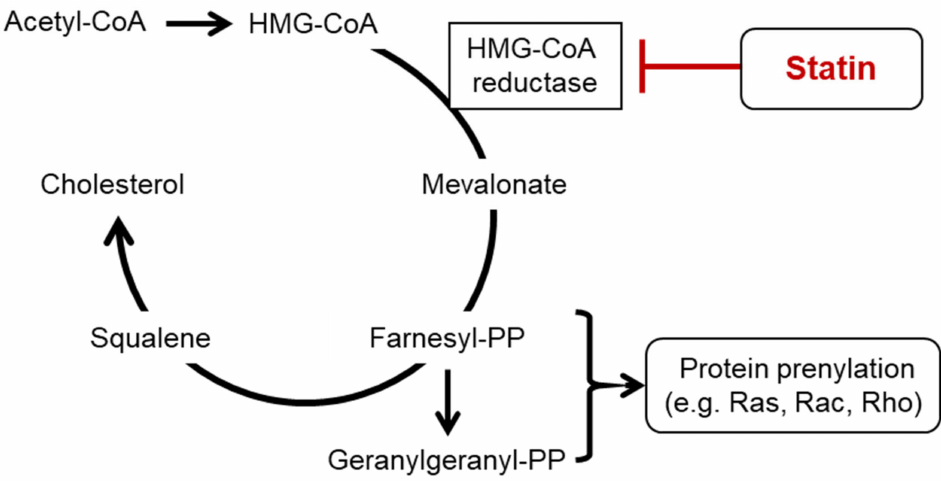
Figure 2. Action of cholesterol and statins on the isoprenoid biosynthesis pathway. Statins, which inhibit 3-hydroxy-3-methylglutaryl-coenzyme A (HMG-CoA) reductase, suppress not only the biosynthesis of cholesterol but also that of isoprenoids. Low molecu- lar weight G-proteins (small G-proteins) of the Rho and Ras families are subject to activation modulation through post-transcriptional modification with isoprenoid biosynthesis inter- pyrophosphate (geranylgeranyl-PP). Small G-proteins regulate cellular proliferation,